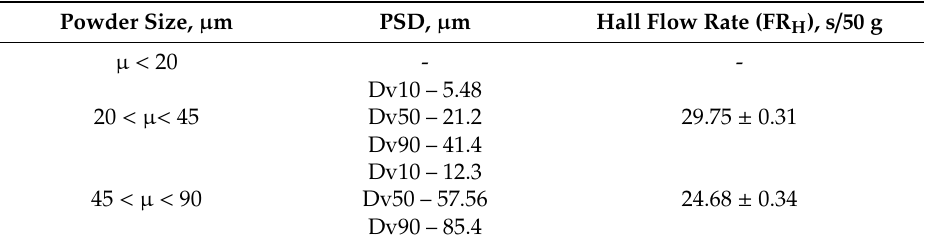
Table 3. Particle size distribution (PSD) and Hall flow rate of TiB 2 -Si powders. Powder Size, µ